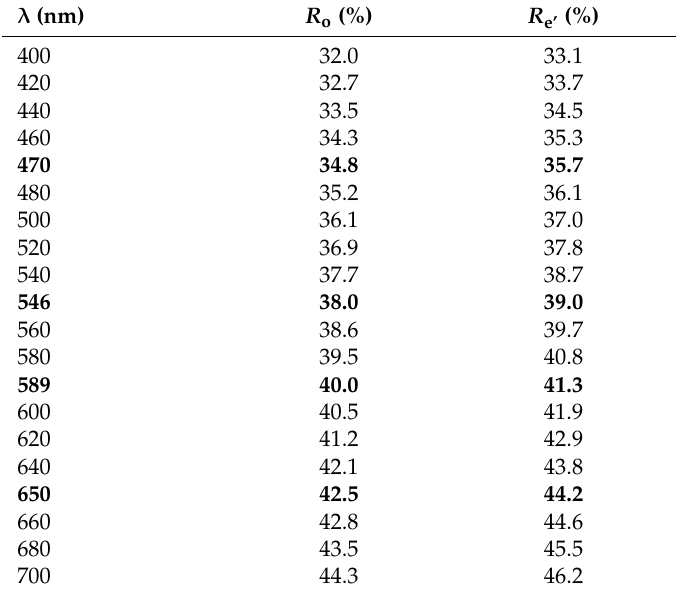
Table 2. Reflectance values of eliopoulosite, those required by the Commission on Ore Mineralogy (COM) are given in bold.